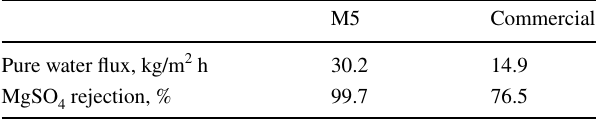
Table 5 Performance of M5 and a commercial membrane in the same operating